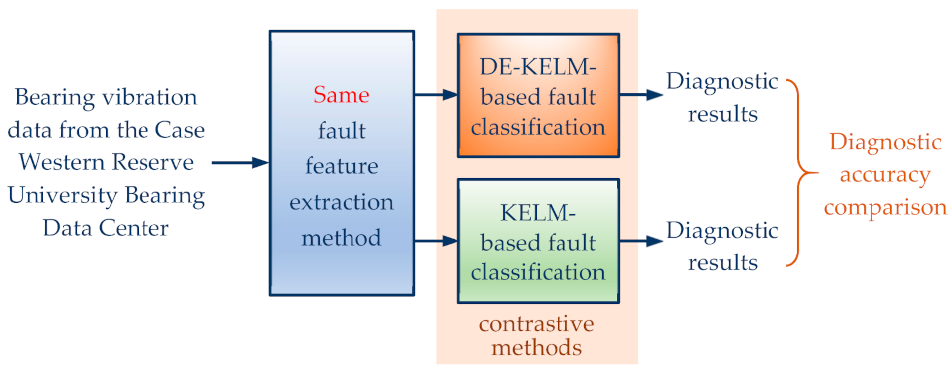
Figure 12. Contrast experiment of DE-KELM-based and KELM-based fault feature classifications.